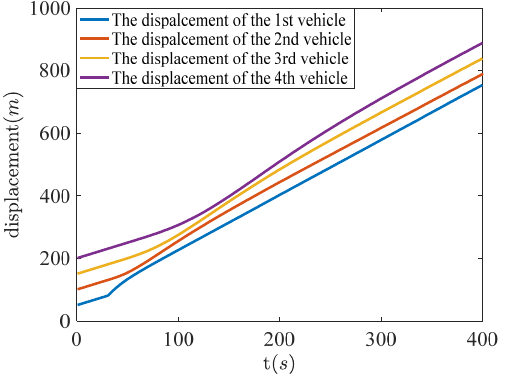
Figure 9. Displacements of four vehicles with the use of fault-tolerant control scheme.